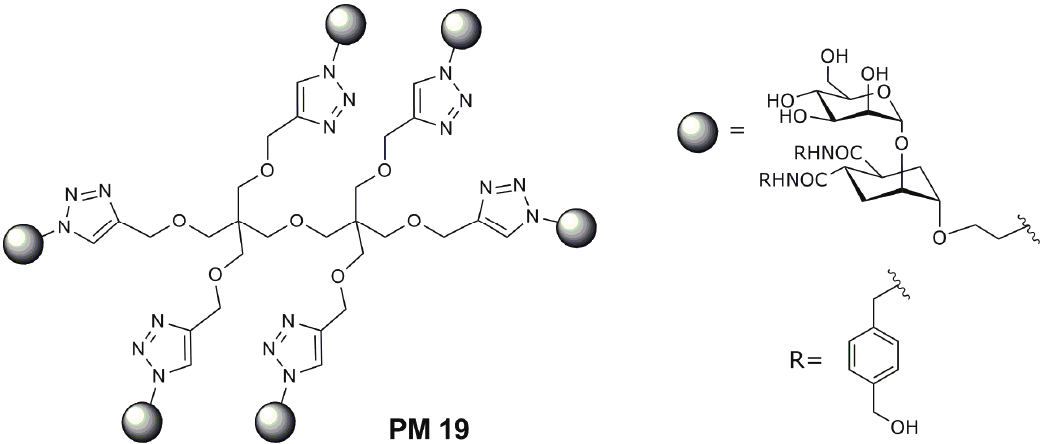
Figure 1. Structure of the hexavalent compound, Polyman 19 ( PM 19 ) (on the left side). The detailed structure of the bisamide-based DC-SIGN ligand is reported on the right hand